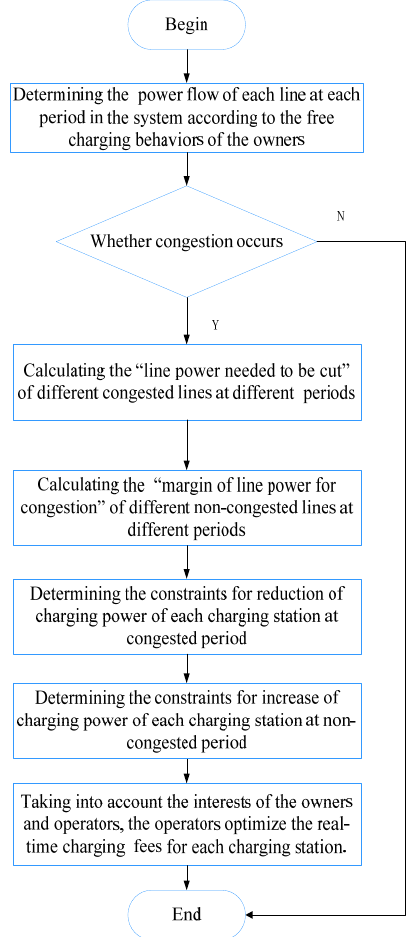
Figure 1. Congestion dispatching model for active distribution network.